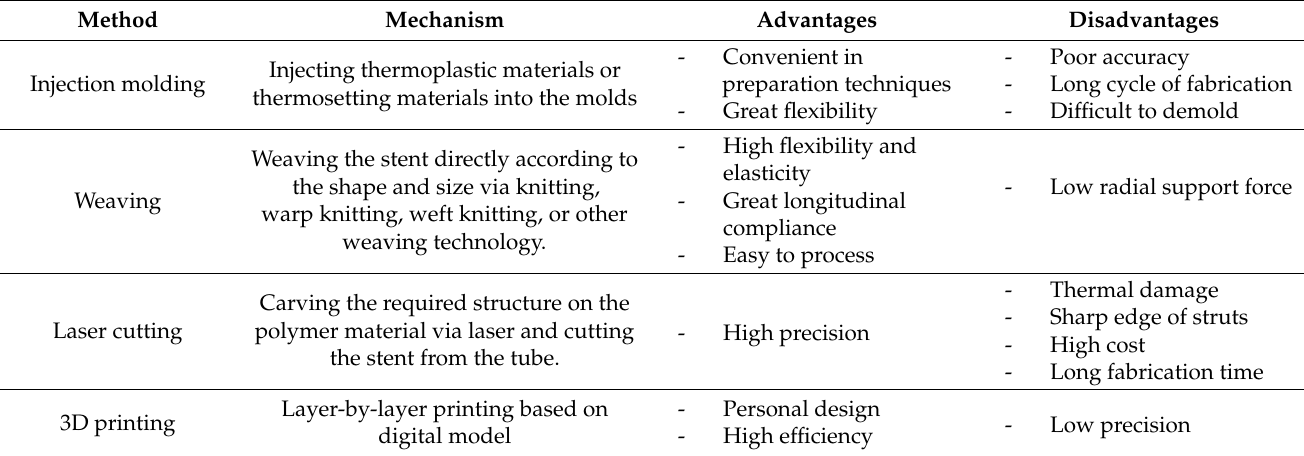
Table 1. Comparison among manufacturing methods of biodegradable polymeric